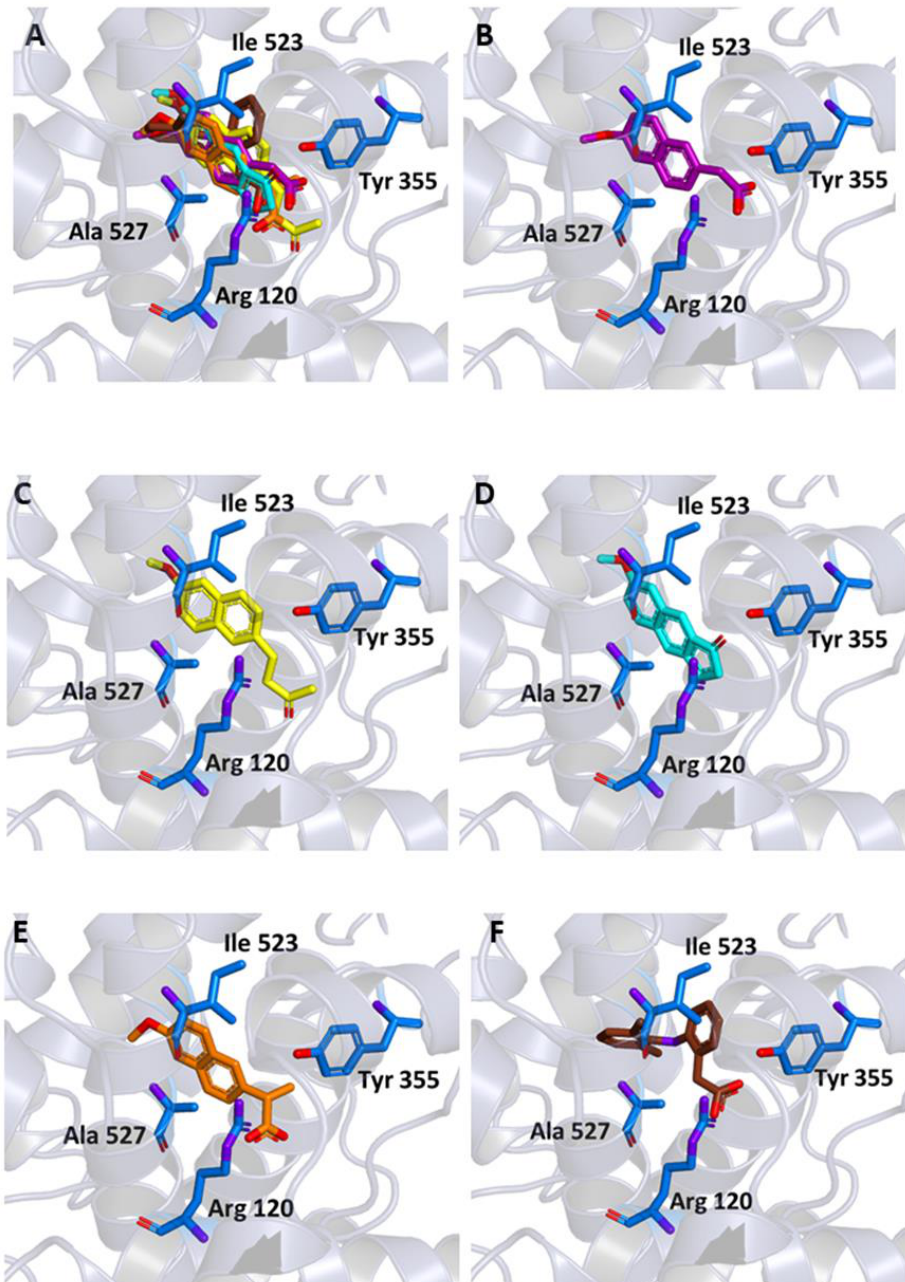
Figure 5. Ligand binding into the active site of COX-1. Protein backbone is represented in background as ribbons and only key residues are highlighted. ( A ) Superimposed binding modes of MNA (purple), NB (yellow), MC (cyan), NAP (orange), and DIC (brown). The ligands are also shown separately: ( B ) MNA, ( C ) NB, ( D ) MC, ( E ) NAP, and ( F ) DIC.